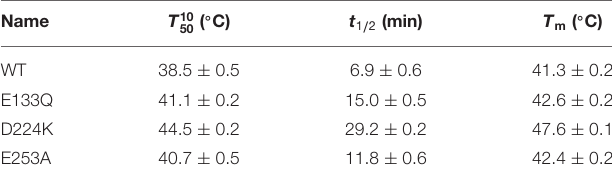
TABLE 1 | The stability of the wild-type and stabilized mutant At -ATAs.